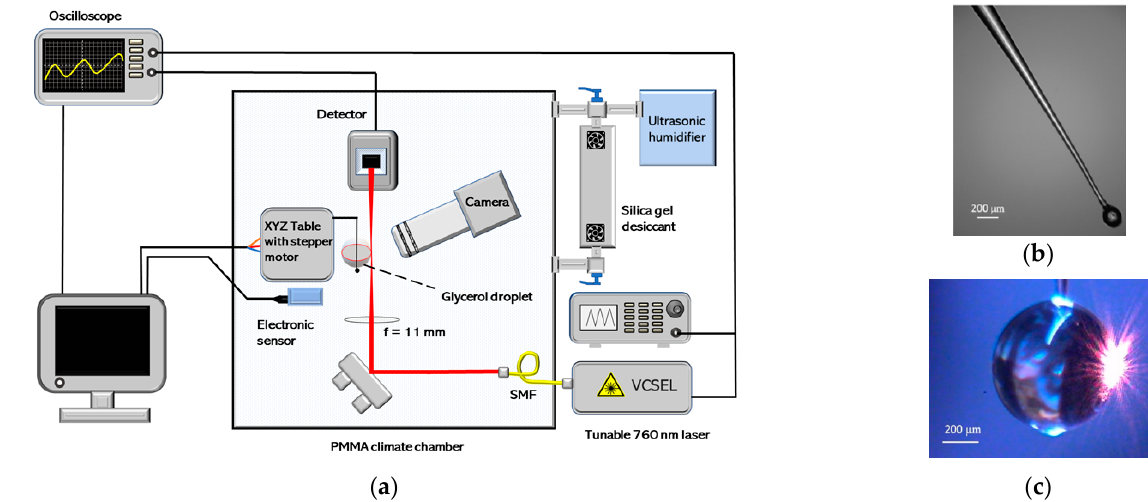
Figure 2. ( a ) Experimental set-up for humidity measurements. After entering the climate chamber, light is reflected from the mirror. The converging lens focuses the light on the side of the glycerol droplet. Photodiode collects WGM transmission spectrum and sends data to the oscilloscope that is operated in AC coupling mode. The electronic humidity sensor for control measurements is positioned a few centimeters away from the droplet; ( b ) Fine tapered fiber with a melted tip to support the droplet; ( c ) Glycerol microsphere created with dipping method. The laser beam was focused on the side of the glycerol droplet to excite the WGM resonances.